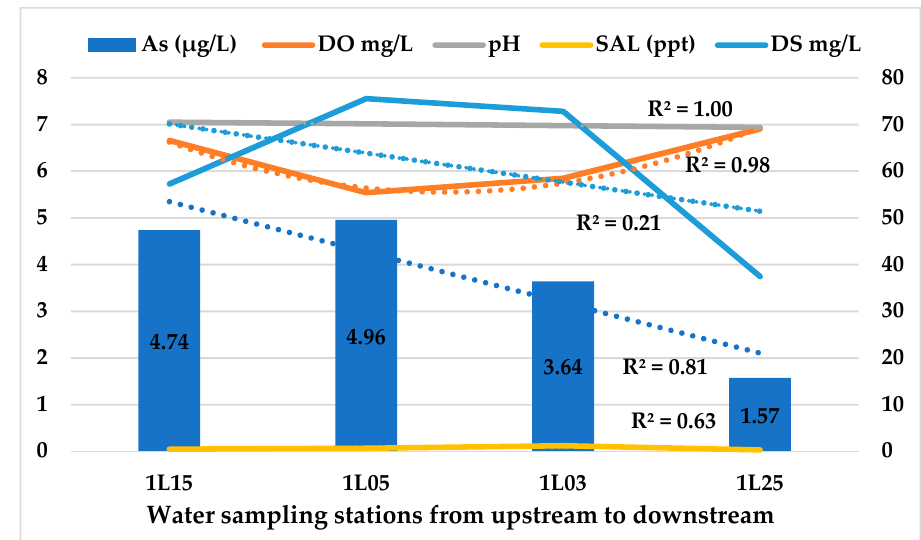
Figure 3. As ( μ g/L) concentration from upstream to downstream in the Langat River. Figure 3. As ( µ g/L) concentration from upstream to downstream in the Langat River. Table 4. Correlation analysis between As ( µ g/L) and physico-chemical parameters in the Langat River.